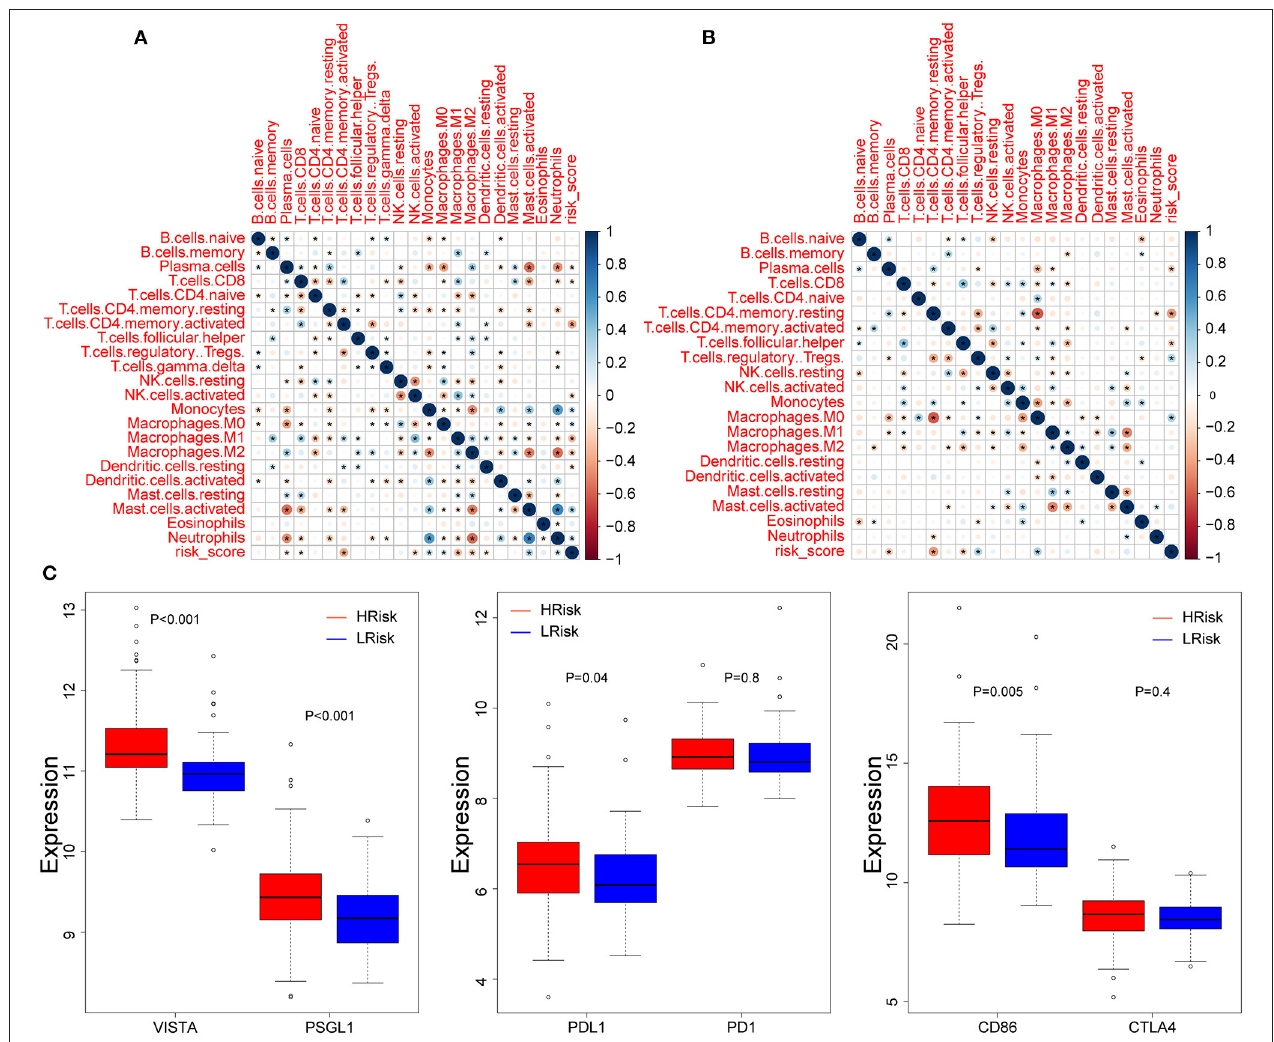
FIGURE 5 | Correlation between immune infiltration and risk score. Correlation between 22 CIBERSORT cell types and risk score in the GEO (A) and TCGA (B) cohorts. (C) Boxplots depicting the expression of neutrophil-mediated T cell immunosuppressive targets between the high-risk and low-risk groups in the GEO cohort. * P <